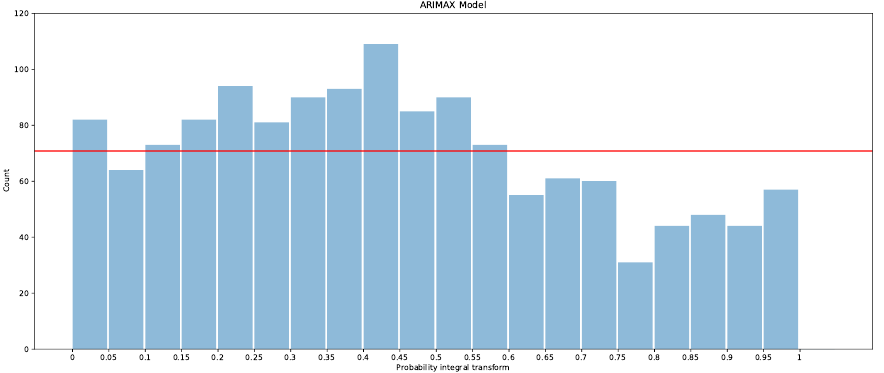
Figure 19. PIT for the ARIMAX model for the first two months of the test